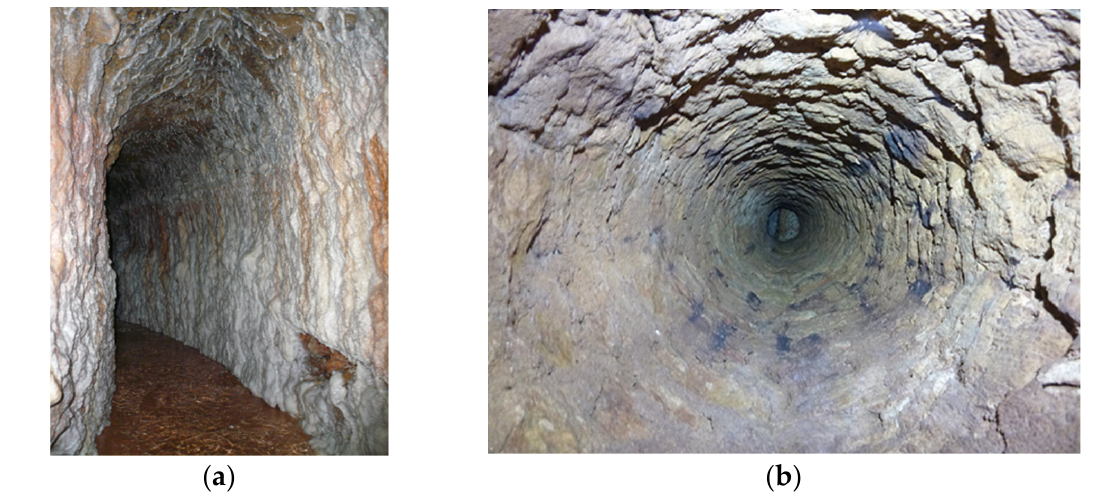
Figure 18. ( a ) Tunnel of the Hadrianic aqueduct. ( b ) Well of the Hadrianic aqueduct.